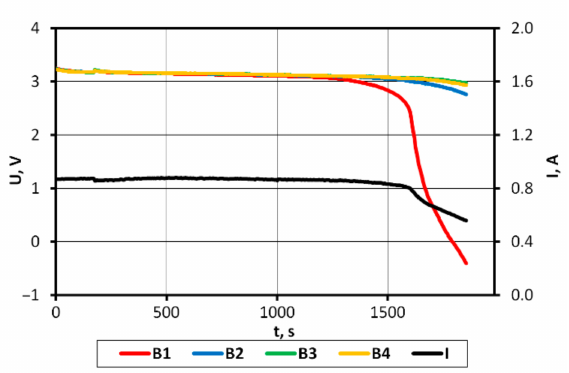
Figure 3. Voltage (U) and current (I) during the discharging using ZEW-type charger.